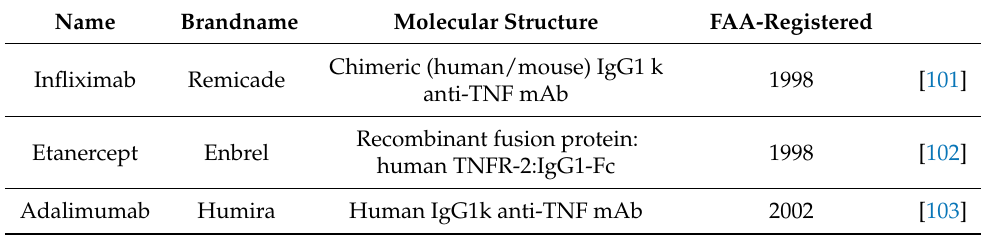
Table 1. “Classical” anti-TNF